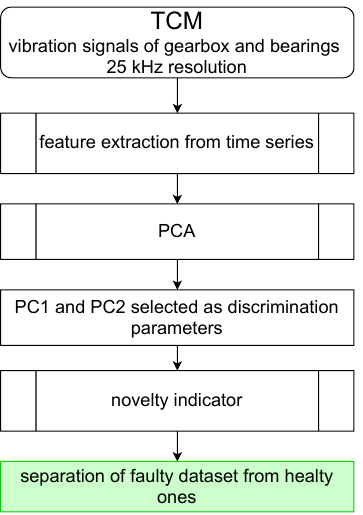
Figure 4. Flow chart of TCM analysis: features extracted from high resolution vibration data were processed with PCA from which it resulted that PC1 and PC2 could be profitably used as discrimination parameters. In the end, a novelty index (NI) was defined to separate the dataset of healthy turbines from damaged